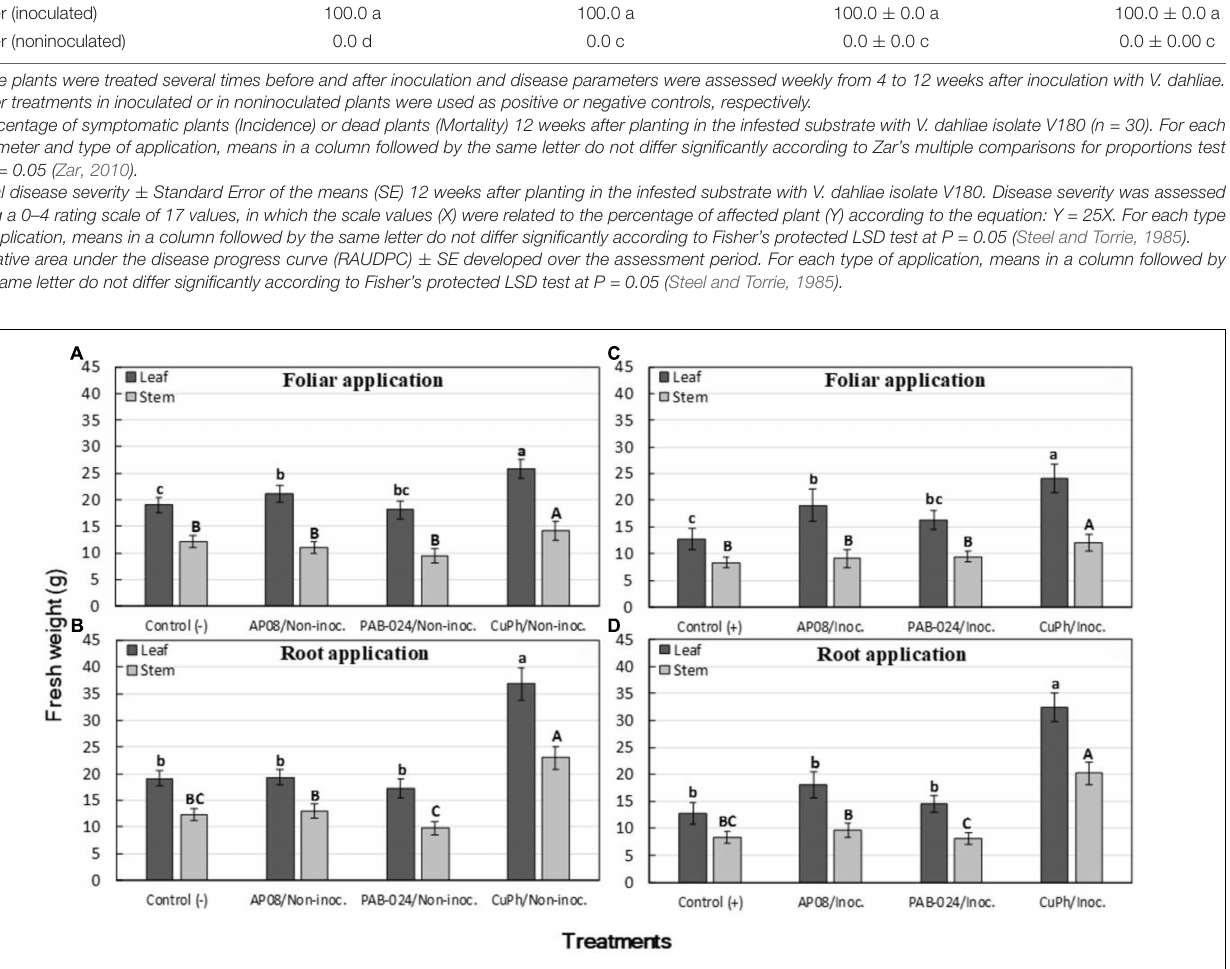
Frontiers in Plant Science |